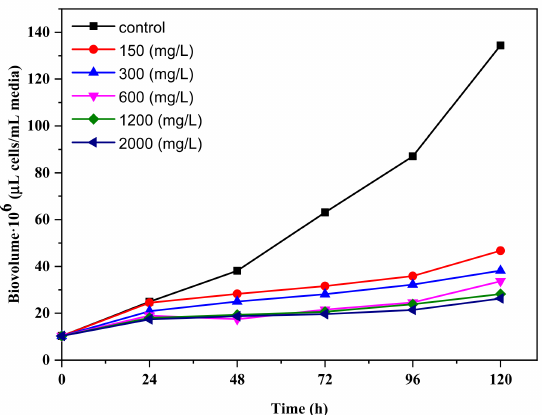
Figure 5. Time-dependent results of biovolume from a batch culture of Chlorella vulgaris under toxic TiO 2 stress.